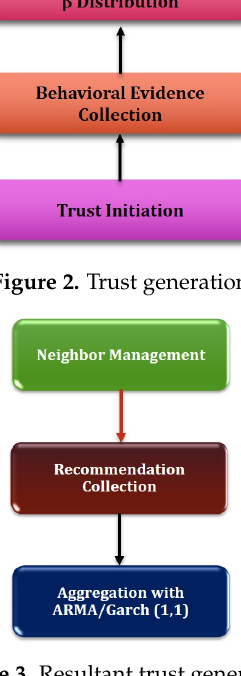
Figure 3. Resultant trust